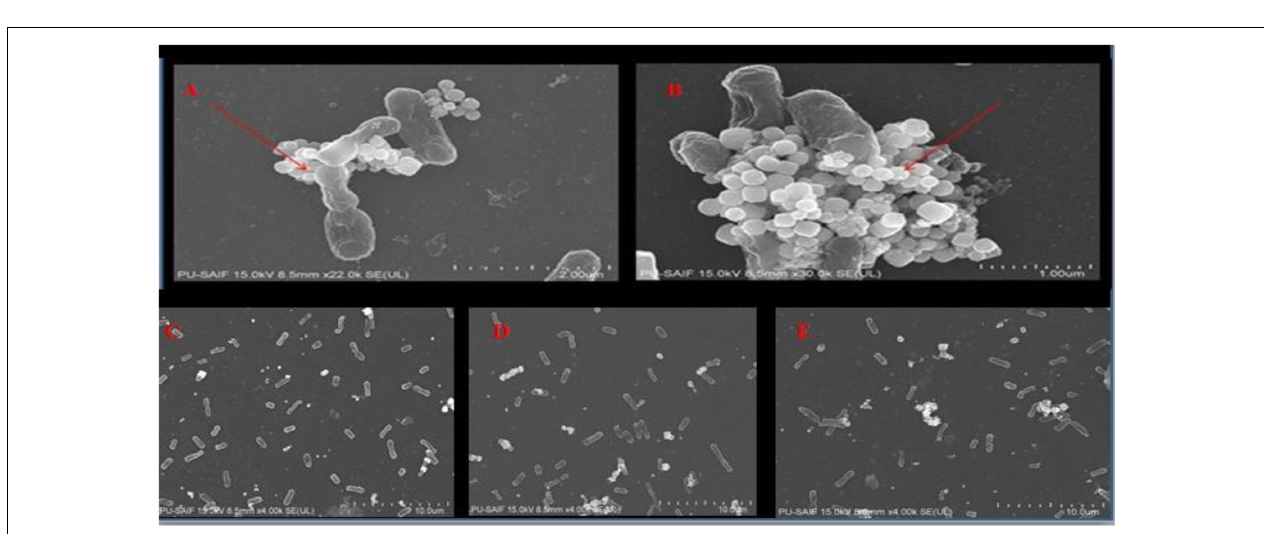
FIGURE 4 | FE-SEM images of bioflim of K. pneumoniae on fifth day Figure 9 (A) , (B) , and (C) (at × 4-25k magnification) show that bioflim forms 3D network and water channels (red arrow) along with EPS matrix.